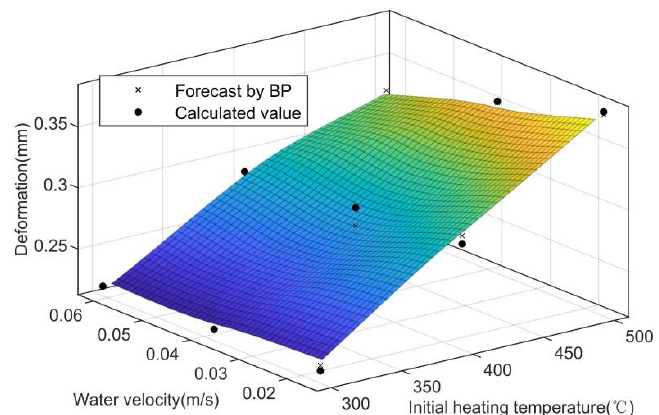
Figure 11. Magnitude of interference fit and relevant factors prediction model. Table 7. The prediction model accuracy of